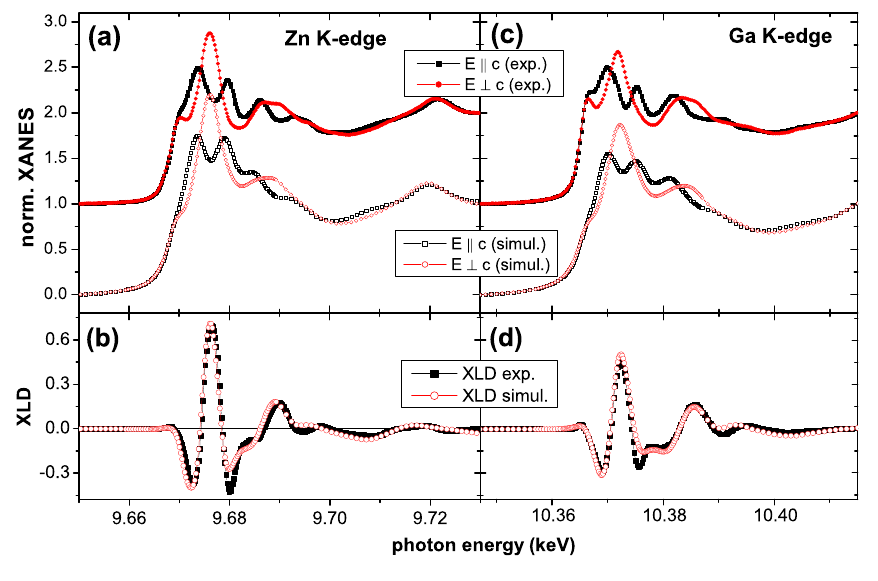
Figure 1. Experimental XANES spectra recorded with E ∥ c (black squares) or perpendicular E ⊥ c (red circles) at (a) the Zn K -edge of c -oriented ZnO and at (c) the Ga K -edge of c -oriented GaN (right). The experimental spectra are shown together with the respective simulations using the FDMNES code. The (b) and (d) show the respective difference between the two experimental (black squares) and simulated (red circles) spectra constituting the characteristic XLD of the ZnO and GaN wurtzite